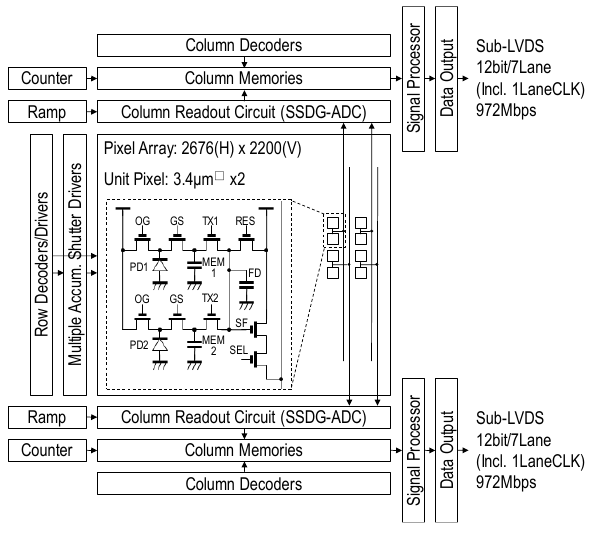
Figure 3. GS CIS block diagram.